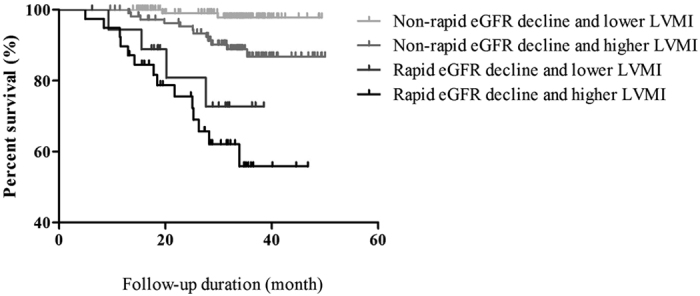
Kaplan–Meier curves for composite outcome-free survival according to eGFR decline rate and LVMI (log rank p < 0.001).Patients with rapid eGFR decline and a higher LVMI had the lowest probability of composite outcome-free survival.